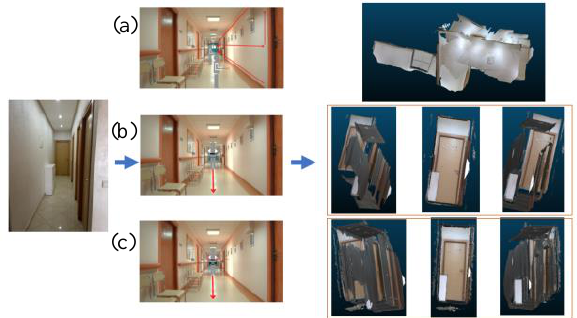
Figure 8. Results of acquisition using the “wall by wall” approach (a), moving according to the trajectory without changing the camera position (b) and moving according to the trajectory by making a left and right sweep (c).